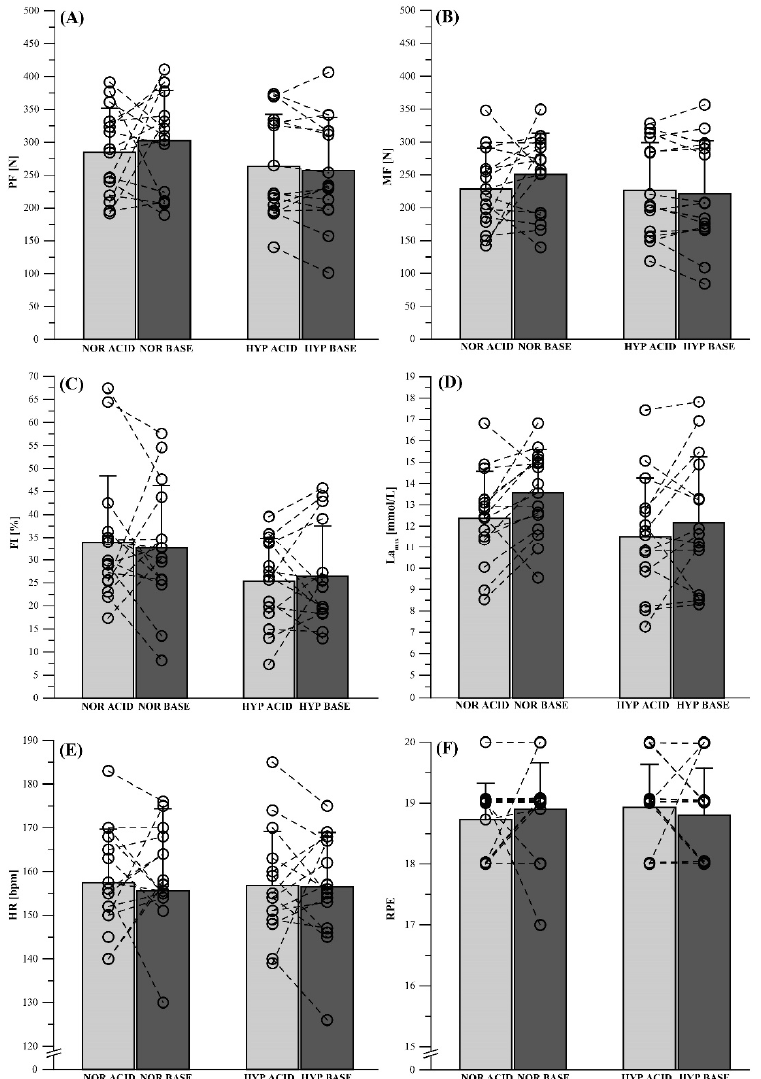
Figure 3. Performance measurements after acidizing (ACID) and alkalinizing (BASE) diet under normoxic (NOR) and hypoxic (HYP) conditions for ( A ) peak force (PF), ( B ) mean force (MF), and ( C ) fatigue index (FI), as well as the associated physiological response ( D ) maximum blood lactate (La max ), ( E ) heart rate (HR), and ( F ) Borg’s rating of perceived exertion (RPE). Data points represent individual values ( ). Bar charts are mean ± standard deviation. See Section 2. Materials and Methods (cid:35) for further